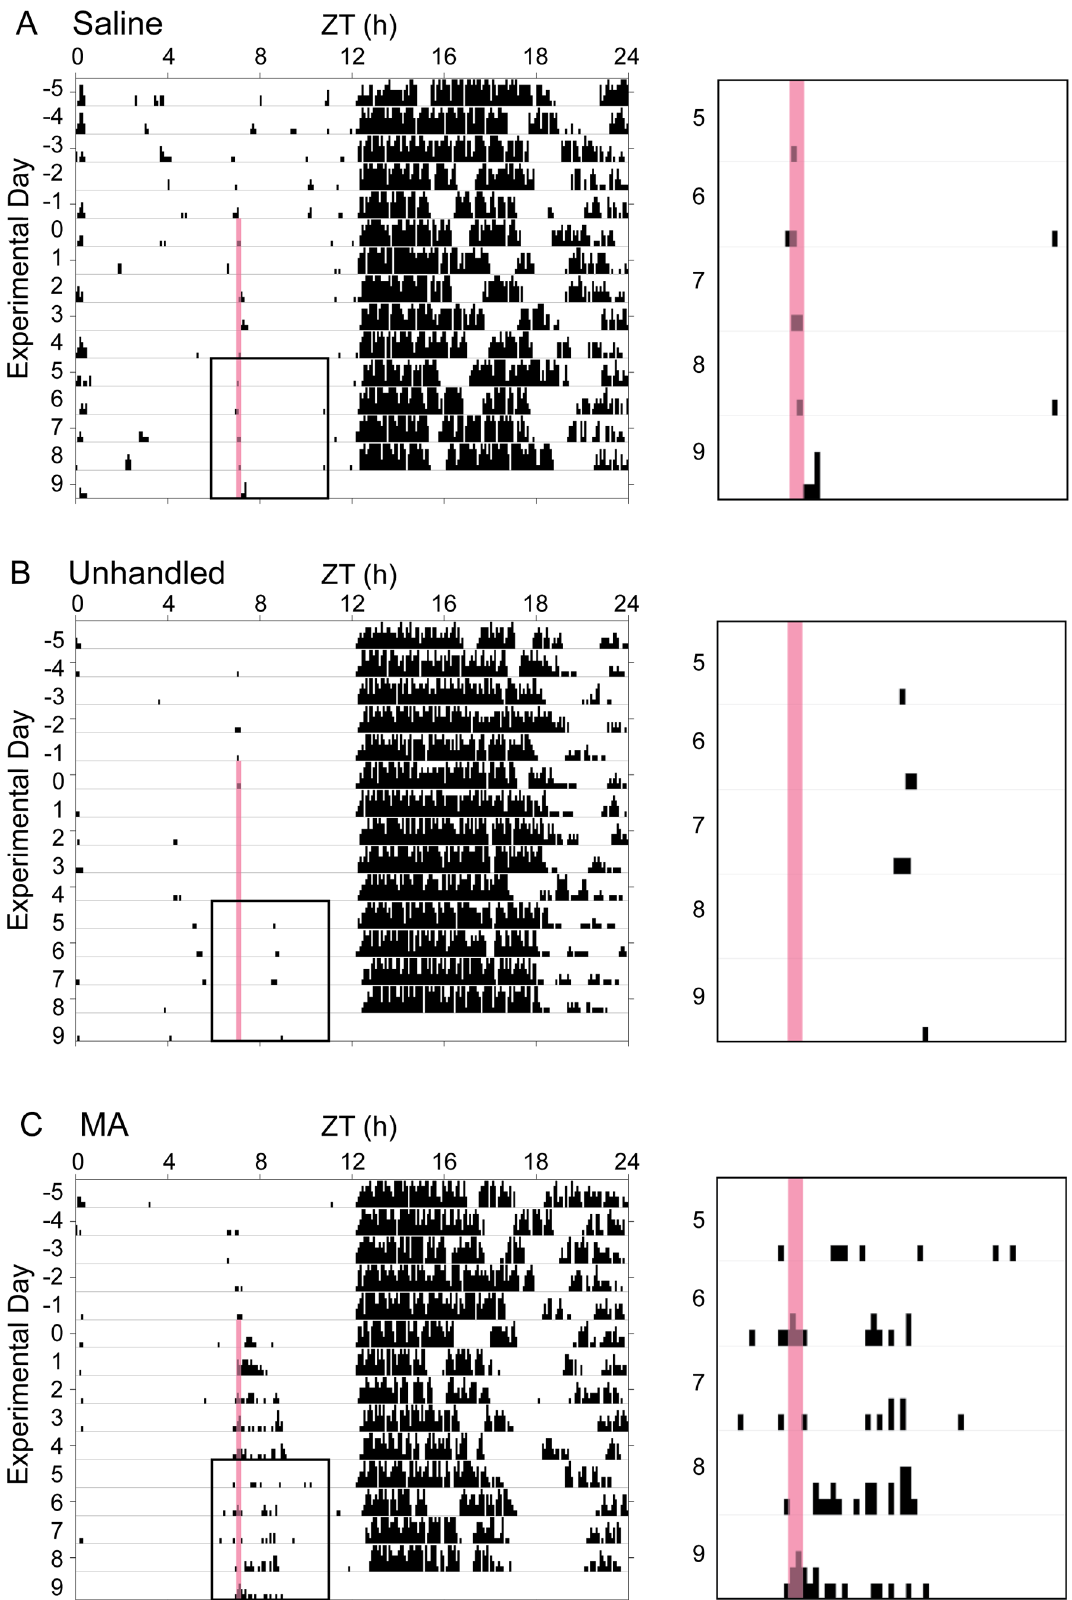
Figure 1. Circadian locomotor activity. Wheel running actograms from representative animals in the saline-injected (A), unhandled (B), and MA- injected (C) conditions. Mice in the injected conditions received 10 daily injections at ZT7. The pink bar indicates the time of injection (or time of